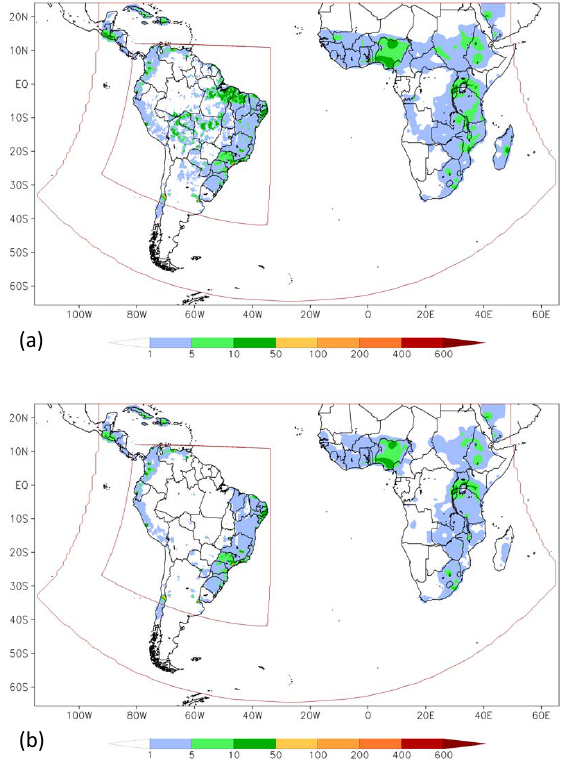
Fig. 4. CO emission rates (10 − 5 kgm − 2 day − 1 ) for BARCA A (a) and BARCA B (b) periods from PREP-CHEM-SRC within the model grid